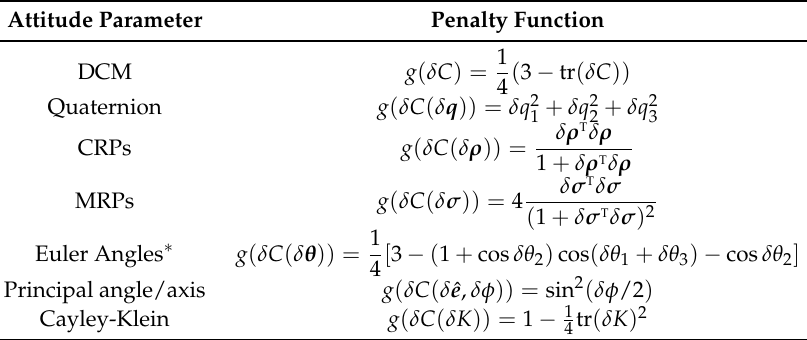
Table 3. Universal penalty function for attitude